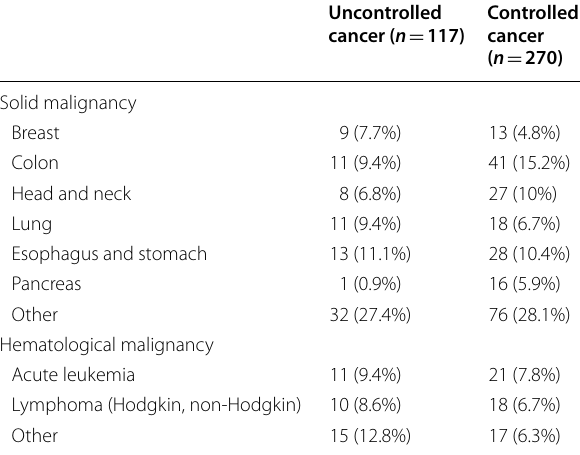
6 patients had both acute leukemia and a solid malignancy (breast cancer, colon cancer and ‘other cancer’), 3 patients had both lymphoma and a solid malignancy (breast cancer, head and neck cancer and ‘other cancer’)